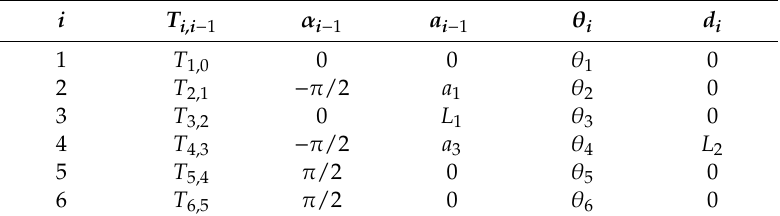
Figure 3. The kinematic scheme of the articulated robot. Table 2. Denavit Hartenberg table of the articulated